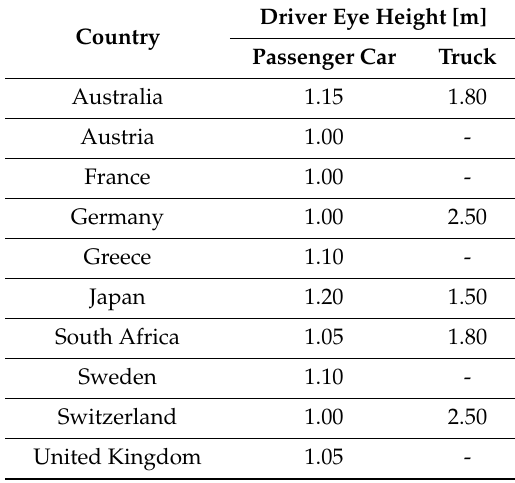
Table 4. Driver’s eye height h 1 adopted in some